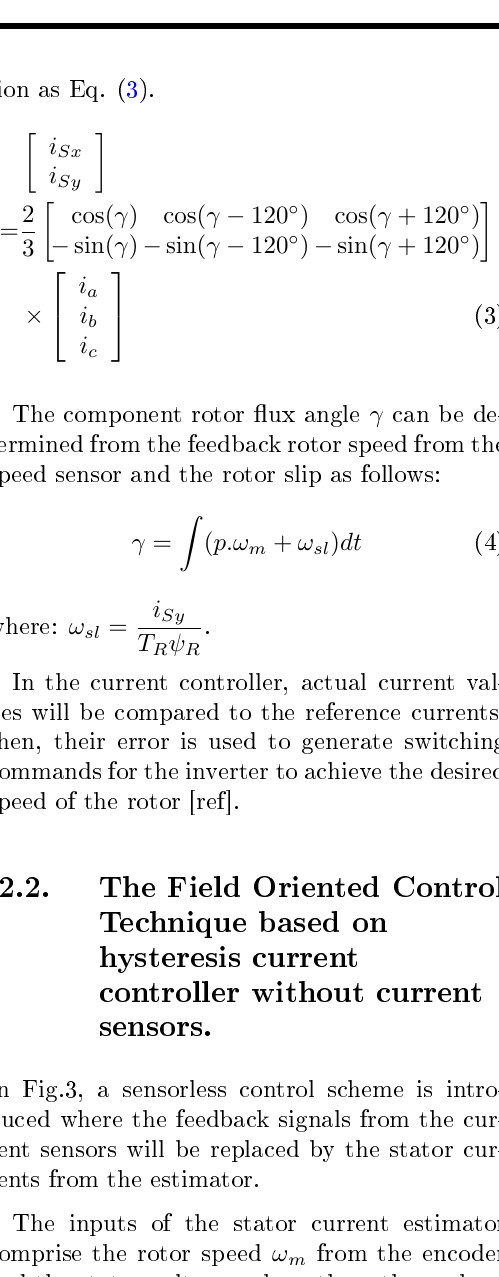
2. The Field Oriented Control Technique based on hysteresis current controller without current sensors. In Fig.3, a sensorless control scheme is introduced where the feedback signals from the current sensors will be replaced by the stator currents from the estimator. The inputs of the stator current estimator comprise the rotor speed ω m from the encoder and the stator voltages where these three-phase voltages [u a , u b , u c ] will be transformed to the two-phase α-β stationary coordinate system by Clarke